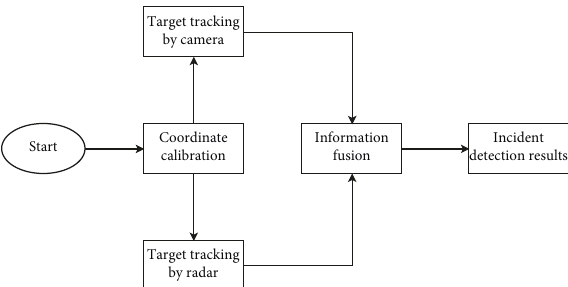
Figure 6: Radar-camera incident detection system flow.